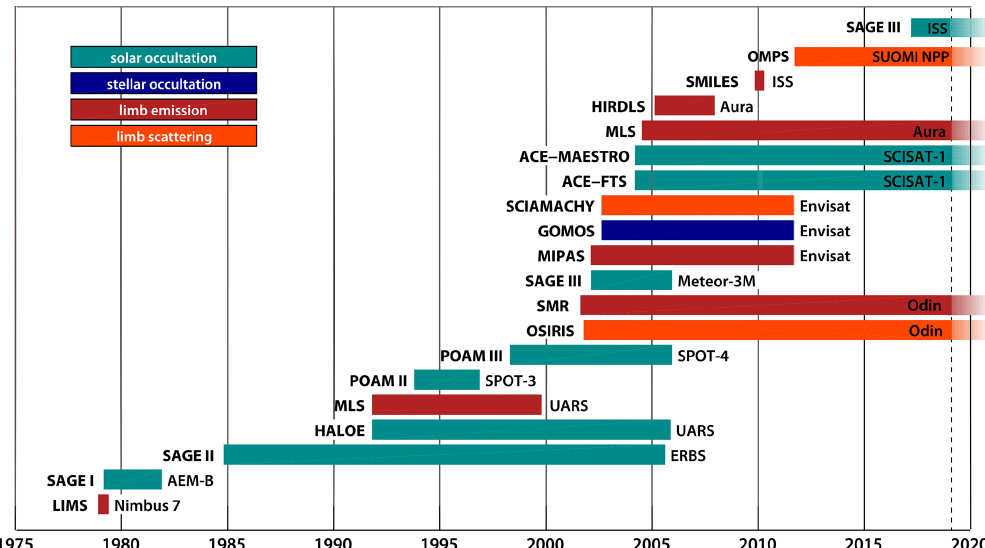
Figure 1. Mission lifetime of limb satellite instruments (left-hand side of bars) evaluated within the SPARC Data Initiative. Also indicated are the mission platforms (right-hand side of bars). The colors classify the instruments according to their observation geometry. Note that the SPARC Data Initiative Report (SPARC, 2017) only evaluated zonal monthly mean datasets up to 2010. Here, we evaluate the datasets up to 2018. Seven satellite limb sounders currently remain in space: Aura-MLS, ACE-FTS, ACE-MAESTRO, Odin/SMR, OSIRIS, OMPS, and SAGE III/ISS, of which the first five long passed their expected lifetimes.